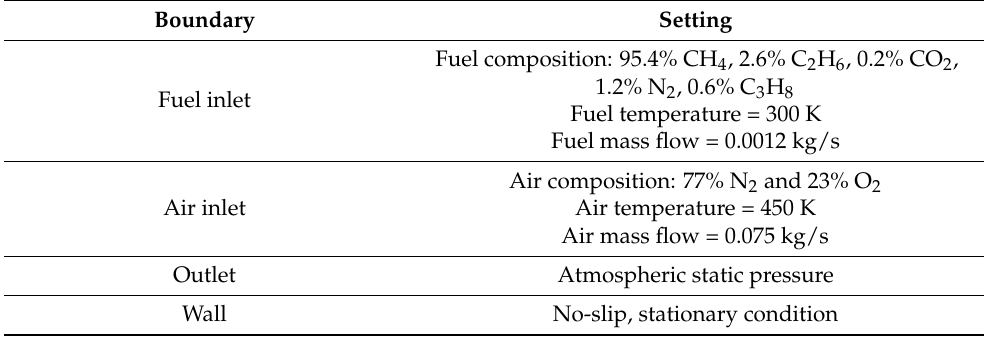
Table 2. Boundary condition